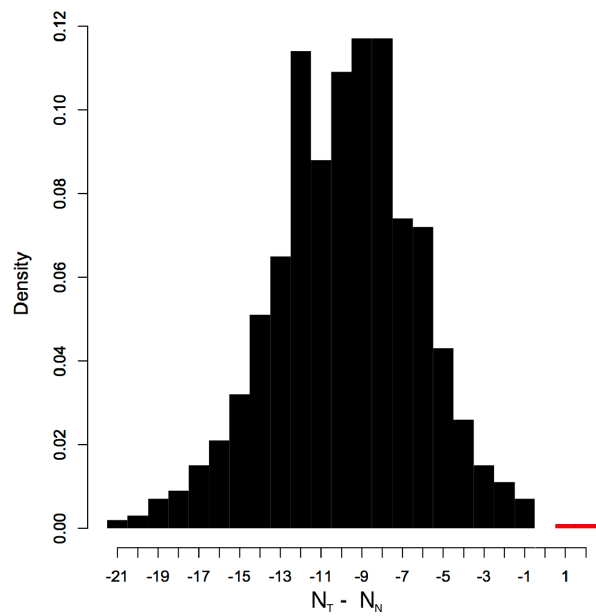
Figure 3. Experimental Selection. This plot is a histogram comparing number of experiments to determine an underlying network given partial initial information. The categories are the number of simulated experiments using T -derived entropy ( N T ) minus the number using using naive entropy ( N N ), so the black region corresponds to the relative amount where T performs better, and the leftmost columns correspond to the greatest advantage. This sample mixes the results from considering 10 k supporting networks from each of our 11-element random dynamics. Similar results were obtained for other system sizes.